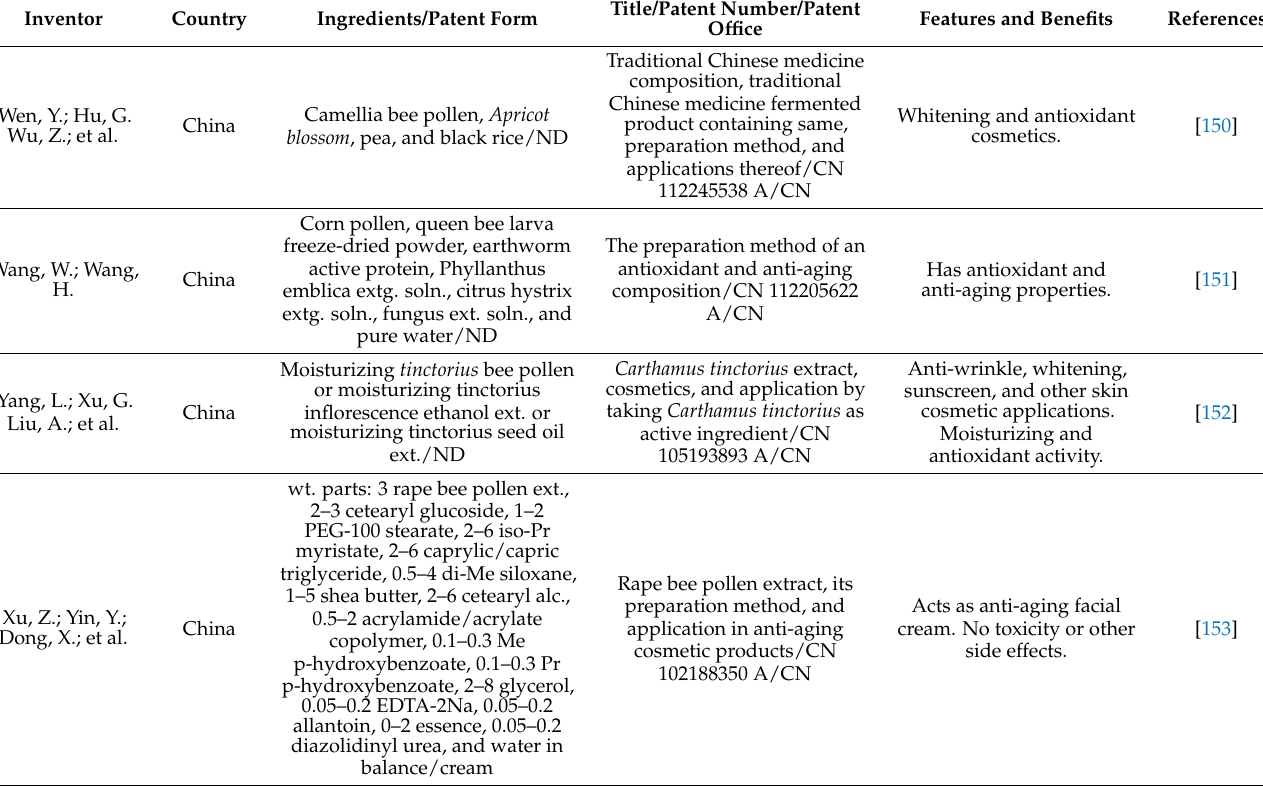
Table 7. Cosmetic applications of bee